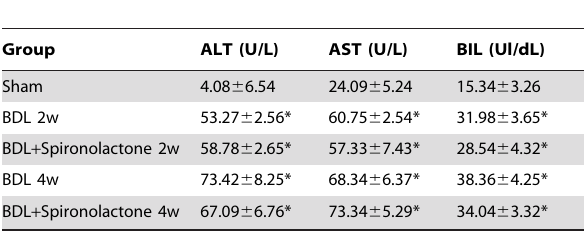
Table 1. Biochemical parameters of different groups (mean 6